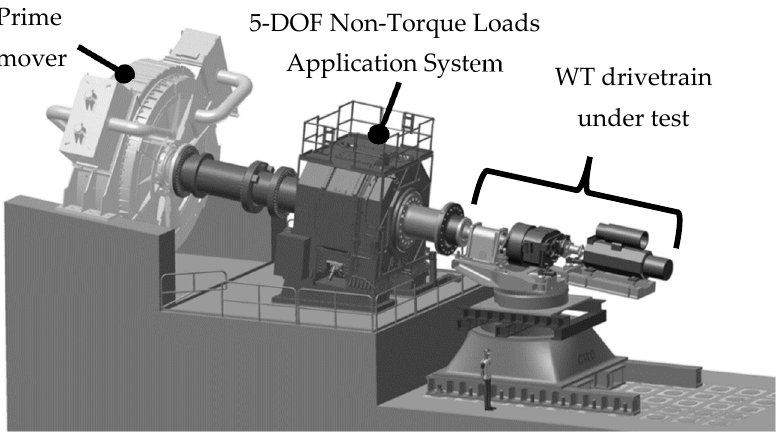
Figure 2. Illustration of the 4 Megawatt WT system test rig during WT drivetrain testing at the Center for Wind Power Drives in Aachen, Germany.